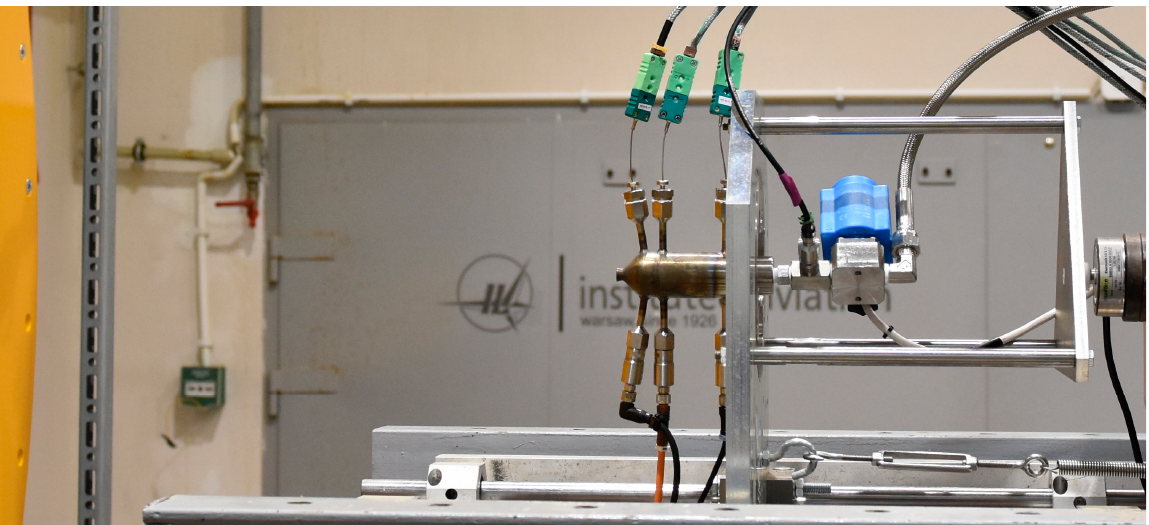
Figure 5. Thruster-like test setup assembled on the test stand.